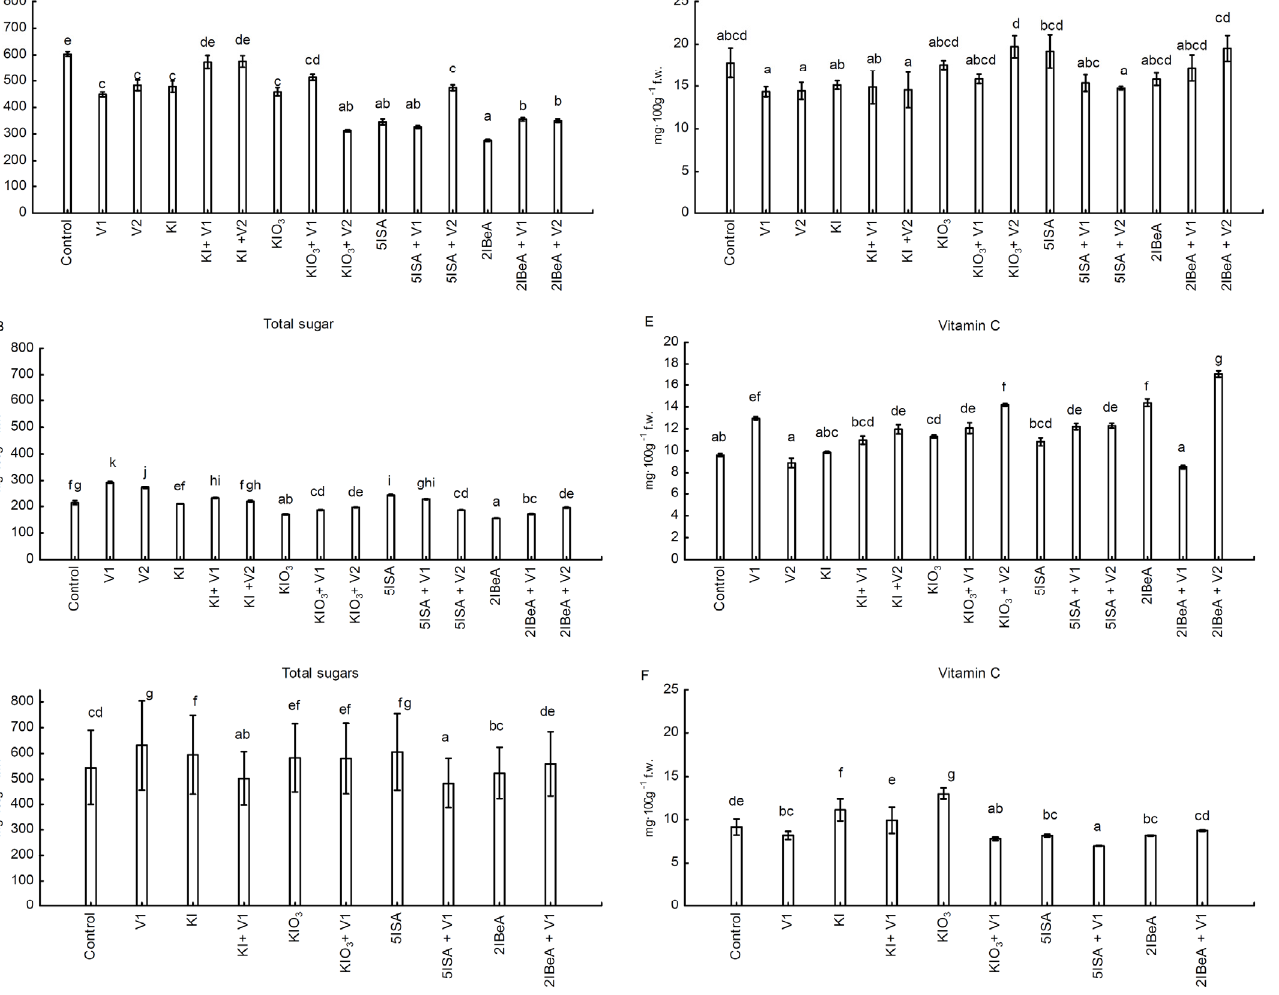
11% for KI + V2 vs. KI increase by 21%; KIO 3 + V1 vs. KIO 3 increase by 6%, KIO 3 + V2 vs.